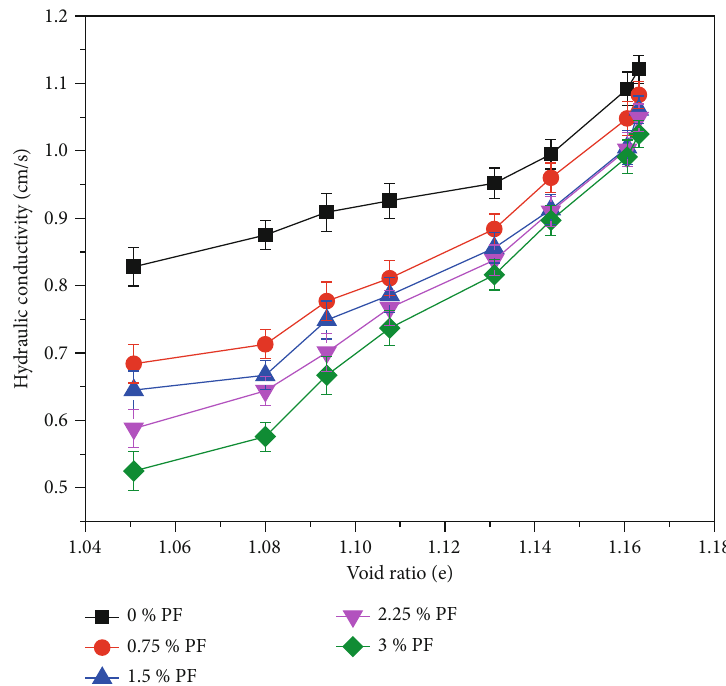
Figure 9: Hydraulic conductivity and void ratio relationship.